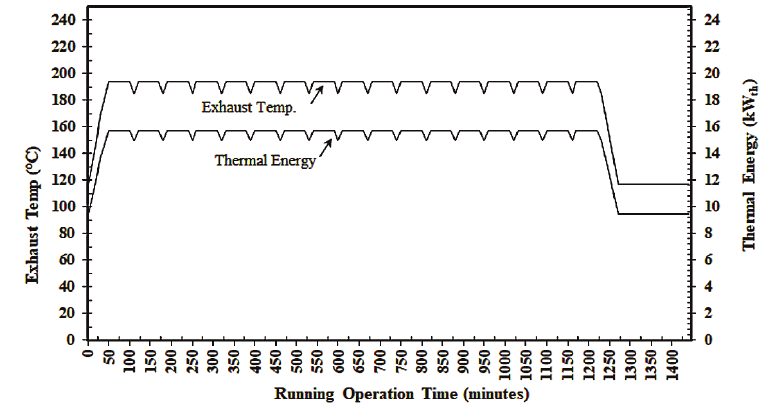
Fig. 2. Exhaust hot air temperature profile and potential energy utilization vs time.